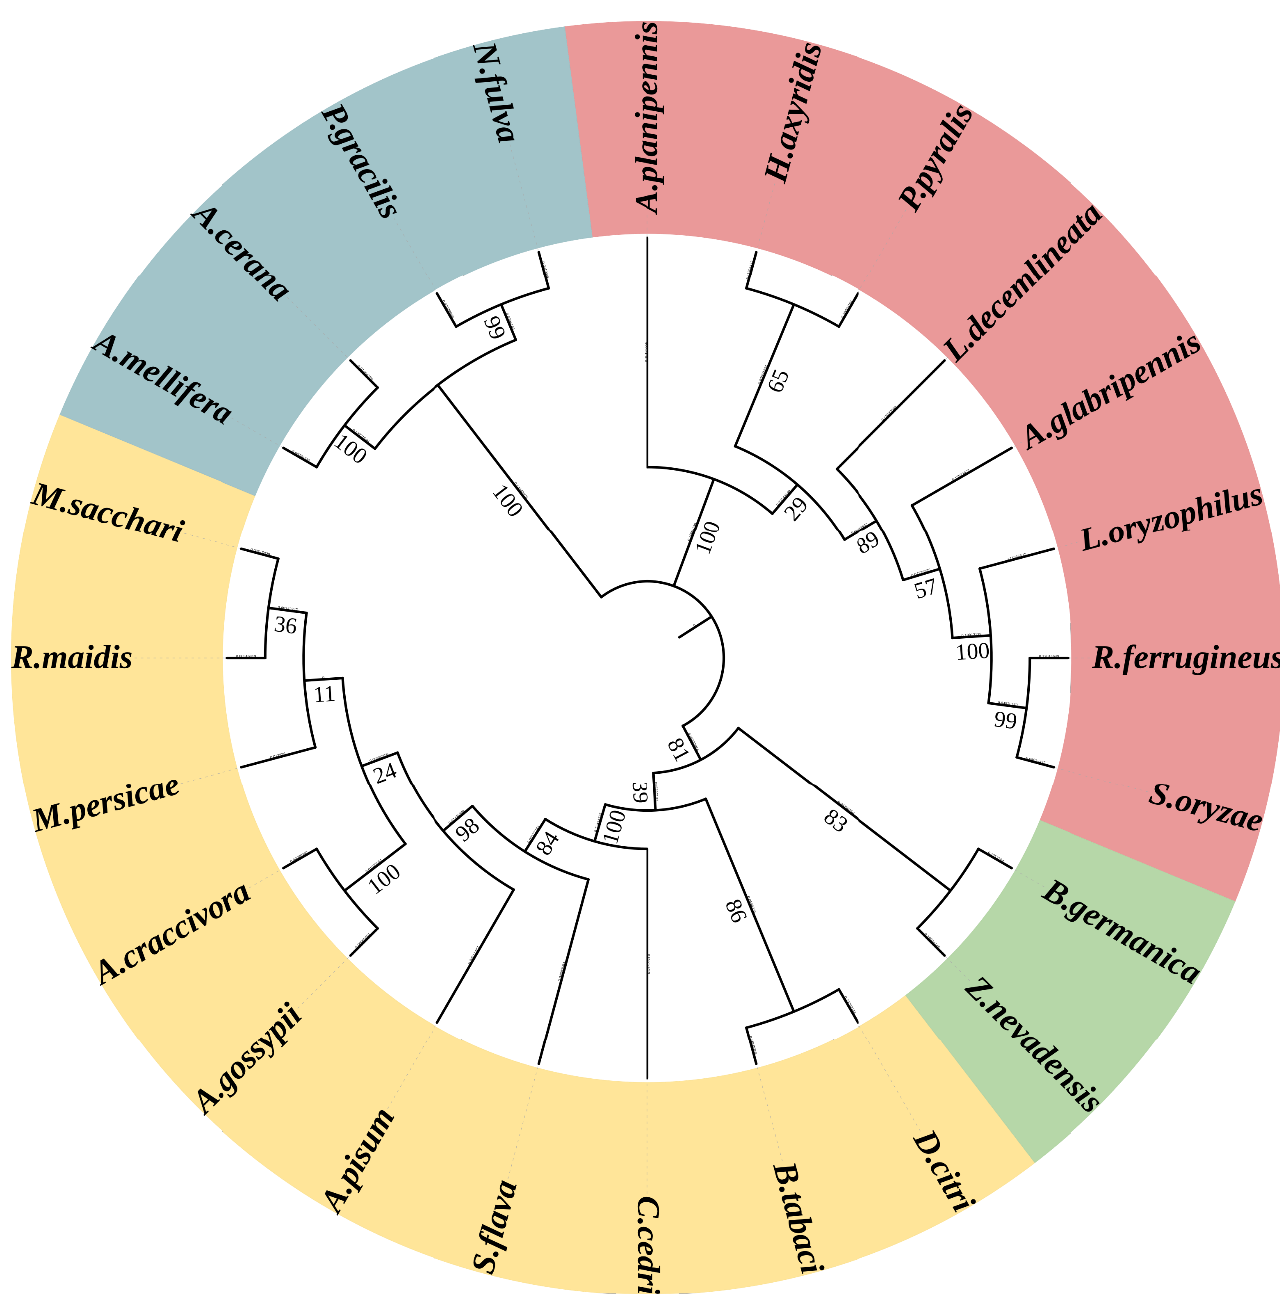
Figure 3. The phylogenetic tree was constructed using the maximum-likelihood method based on amino acid sequence alignment. Full-length amino acid sequences were aligned using the Mega 6 program to generate a phylogenetic tree. A bootstrap analysis was carried out, and the robustness of each cluster was verified in 1000 replications. Red represents Coleoptera, brown represents Hemiptera, green represents Blattaria, and blue represents Hymenoptera. A. mellifera , NP_001106141.1;